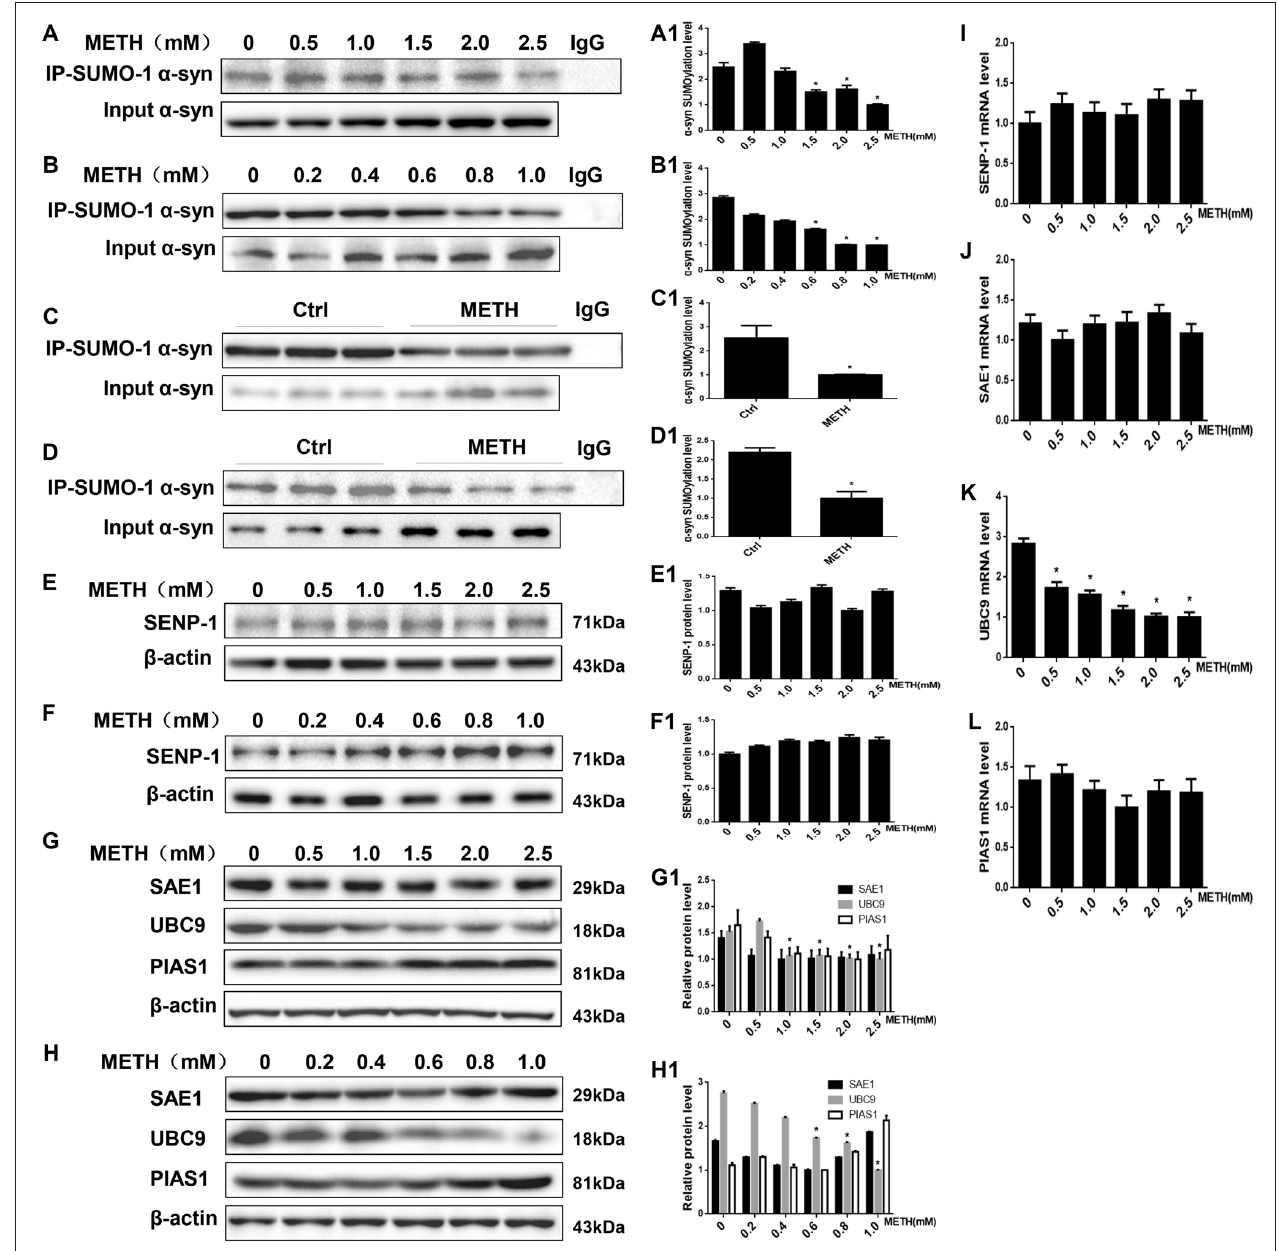
FIGURE 3 | METH decreases the level of SUMOylated α -syn via UBC9. Co-immunoprecipitation results show that METH decreases the level of SUMOylated α -syn in vitro and in vivo . The unique E2-conjugating enzyme, UBC9, is a key factor that is also reduced in METH-induced cells. SH-SY5Y cells (A,A1) and primary cultured neurons (B,B1) were exposed to a range of METH doses for 24 h. Male C57 mice were divided randomly into a control group and a subacute group. Cells (A,B,A1,B1) and tissues (C,D,C1,D1) were immunoprecipitated with an anti-SUMO-1 antibody, followed by western blot with an anti- α -syn antibody. Cells and tissues immunoprecipitated with IgG were used as a negative control. Levels of several enzymes involved in the SUMOylation cycle were measured in SH-SY5Y cells (E,G,E1,G1) and primary cultured neurons (F,H,F1,H1) . Western blot (A–H) and quantitative analyses (A1–H1) were performed to determine the level of SUMOylated α -syn. RT-QPCR (I–L) was performed to determine several enzymes mRNA expression in SH-SY5Y cells. β -Actin was used as a loading control. ∗ p < 0.05 compared with the control group. The data shown in (A,B,E–L) were analyzed using one-way ANOVA followed by LSD post hoc analyses, whereas the data shown in (C,D) were analyzed using the Mann-Whitney U